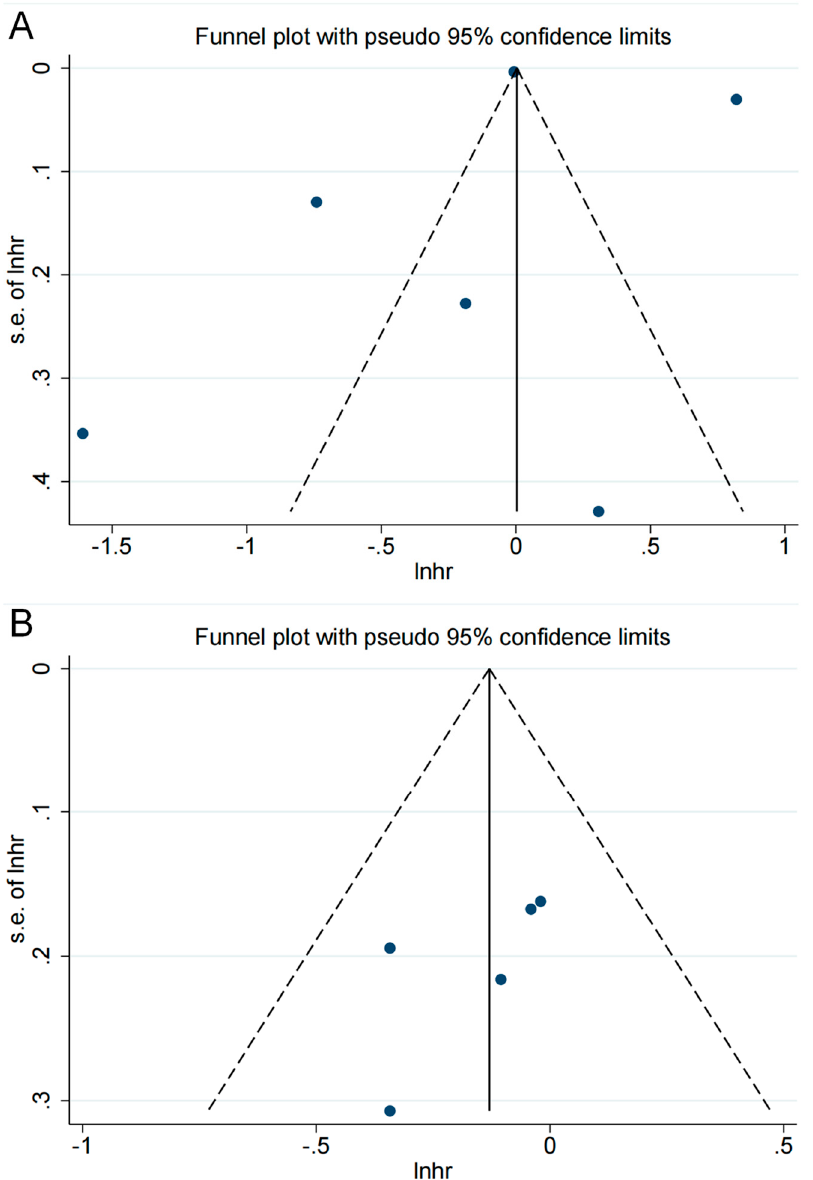
Figure 3. The funnel plot for publication bias assessment: ( A ) in risk analysis; ( B ) in overall survival analysis. The horizontal axis is the scale of the natural logarithm of the effect size, and the vertical axis is its standard error. The solid line perpendicular to the horizontal axis is the natural logarithm of the pooled effect size using the fixed-effects model; the dashed line is the pseudo-95% confidence interval lines. The dots in the graph represent the individual studies included. Studies with larger sample sizes are usually distributed at the top of the graph, while studies with smaller samples are distributed at the bottom. Ideally, studies are evenly distributed on both sides of the solid line.